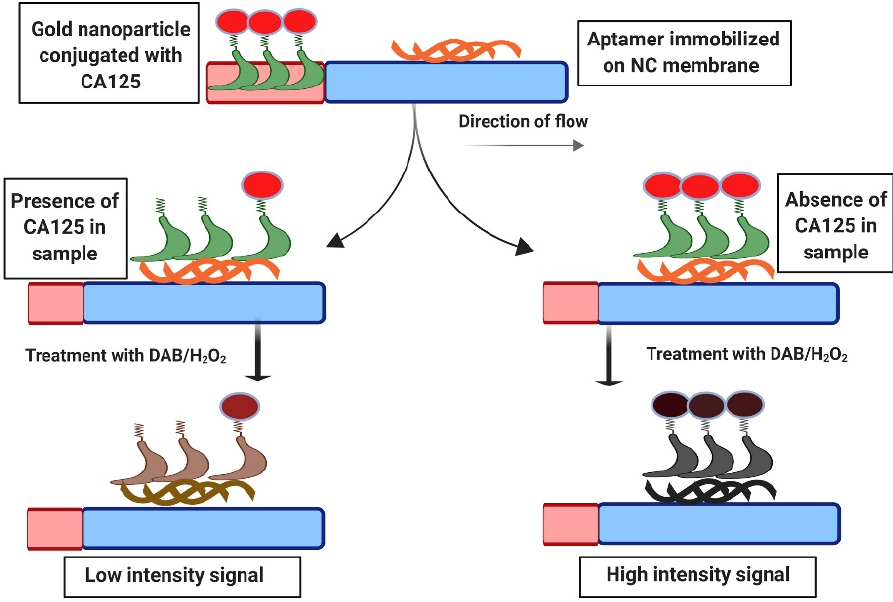
Figure 20. Functioning principle of an Apt–Au nanozyme lateral flow assay for the